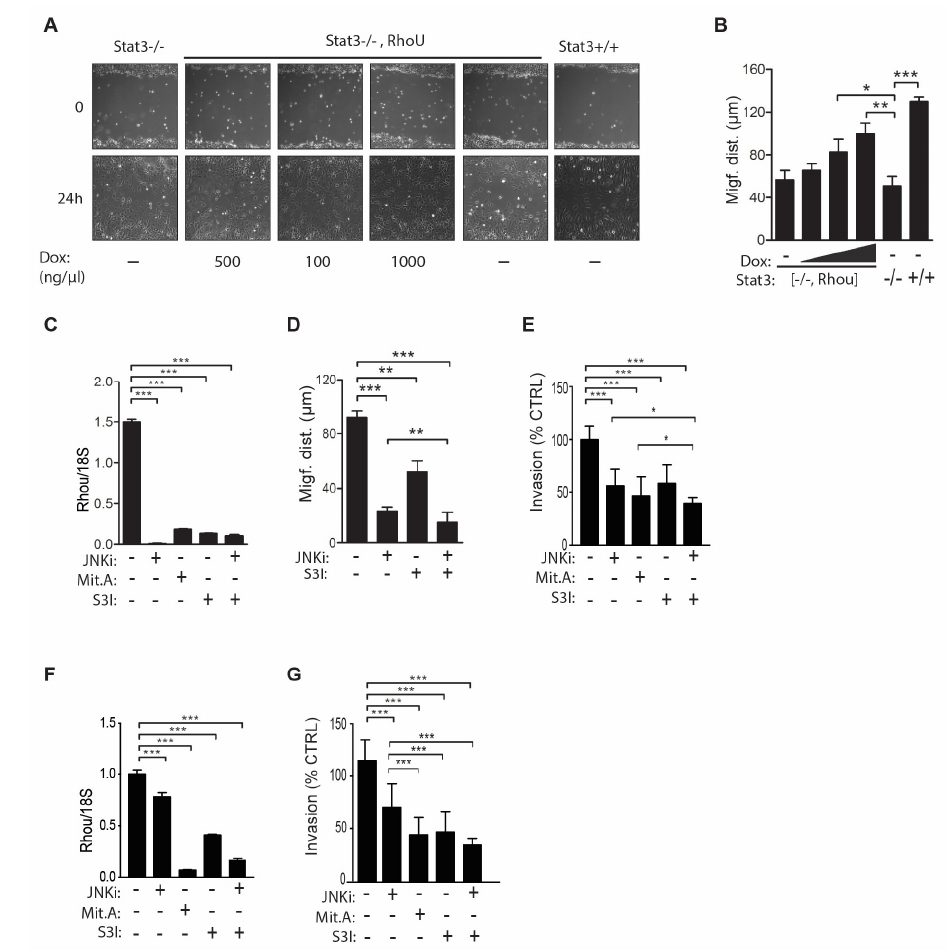
Figure 4. RhoU promotes cell migration also downstream of STAT3 in both MEF and tumor cells ( A , B , D , E , G ). ( A , B ) Wound healing assays with wild type (Stat3 +/+ ) or Stat3-deficient MEF cells, either control (Stat3 − / − ), or expressing doxycycline (Dox)-inducible RhoU (Stat3 − / − , RhoU ), treated or not with the indicated amounts of Dox to induce increasing RhoU expression ( A ), quantified as described in the legend to Figure 3 ( B ). Field of View: 895 × 671 µ m. ( C – E ) MDA-MB-231 cells were treated with the indicated combinations of Mit.A and of the JNK and STAT3 inhibitors (JNKi, S3I), followed by RhoU mRNA quantification by RT-PCR ( C ), wound healing assay (quantified in D ), and transwell invasion assay ( E ). The same inhibitors were used to treat BT549 cells, followed by RNA quantification ( F ) and transwell invasion assay ( G ). ( E , G ) Invasion was calculated as percentage of control cells (vehicle treated). Mean ± SD of three independent experiments. * p < 0.05, ** p < 0.01, *** p < 0.001 between the indicated groups.